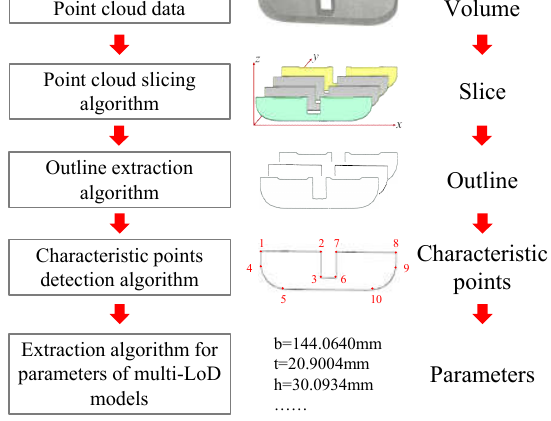
Figure 4. Overall framework.